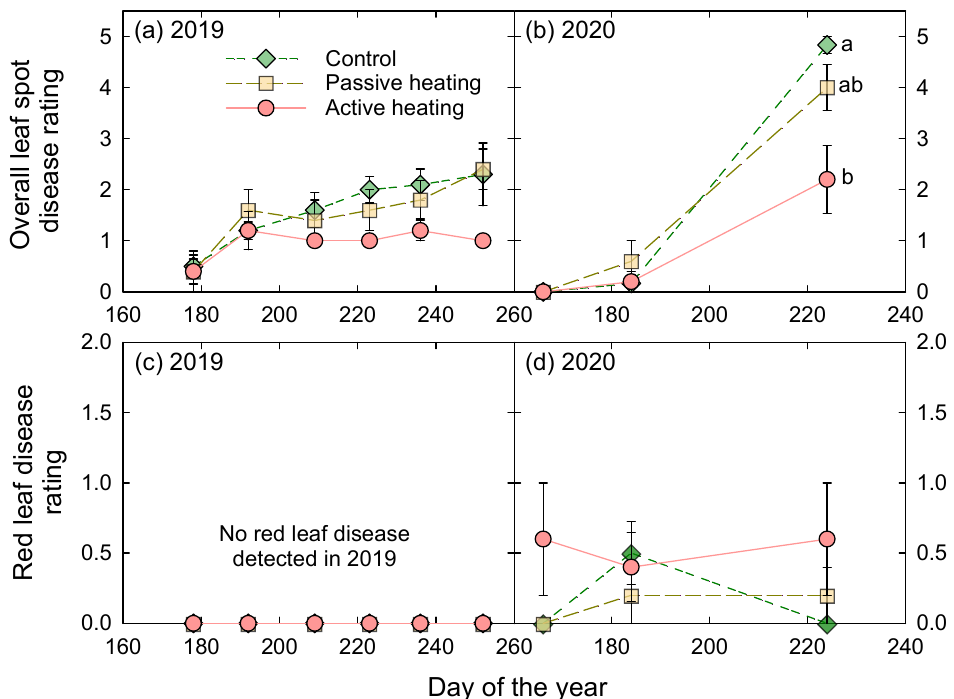
Figure 4. Incidence of overall leaf spot disease ( a , b ) and red leaf disease ( c , d ) of wild blueberries under different treatments in 2019 (prune year; a , c ) and 2020 (crop year; b , d ). The rating ranked from 0–5 (0 = not present, 1 = ≤20%, 2 = 20–40%, 3 = 40–60%, 4 = 60–80%, 5 = 80–100%) of the control plots (CON), passive-heating OTCs (PH) and active-heating OTCs (AH). Data are means ± SEs. Green diamonds with dashed lines denote the ambient control plots (CON), yellow squares with dashed lines are passive heating (PH) OTCs, while the red circulars with solid lines indicate the active heating (AH) OTCs. The absence of letters or points with the same letter indicate treatments that do not differ significantly ( p > 0.05).